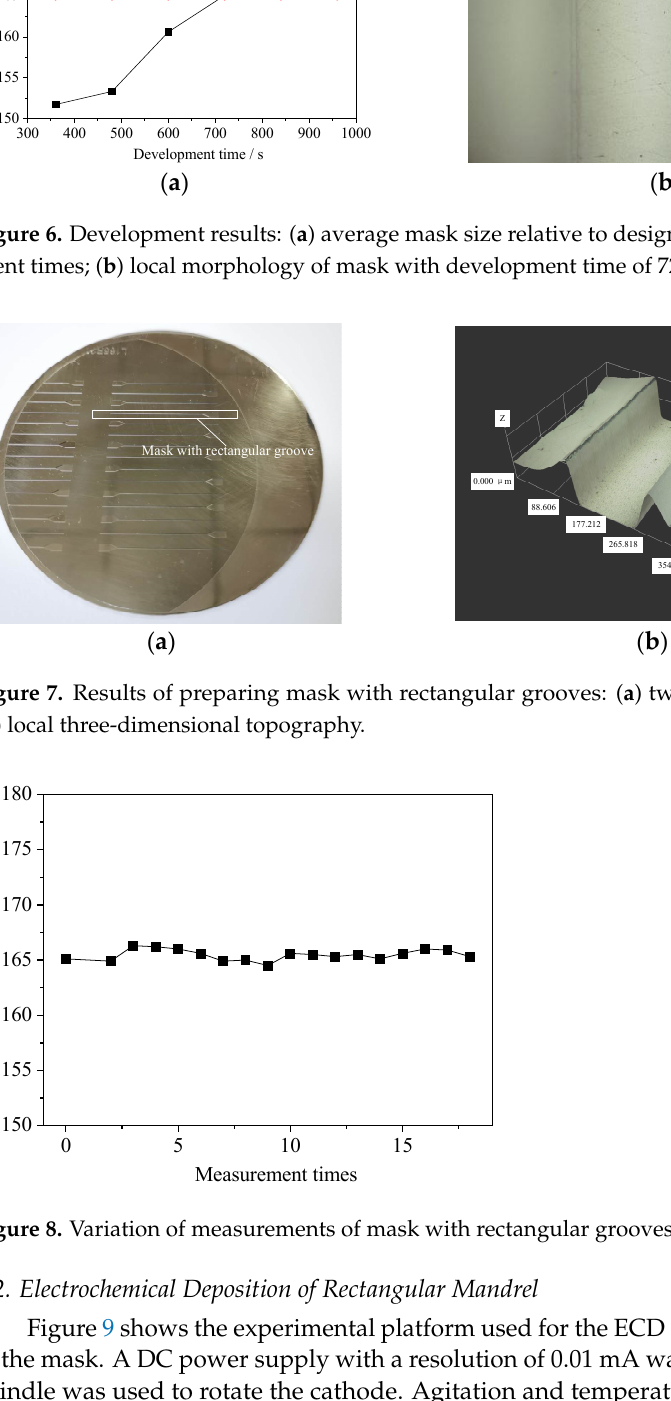
Figure 8. Variation of measurements of mask with rectangular grooves.